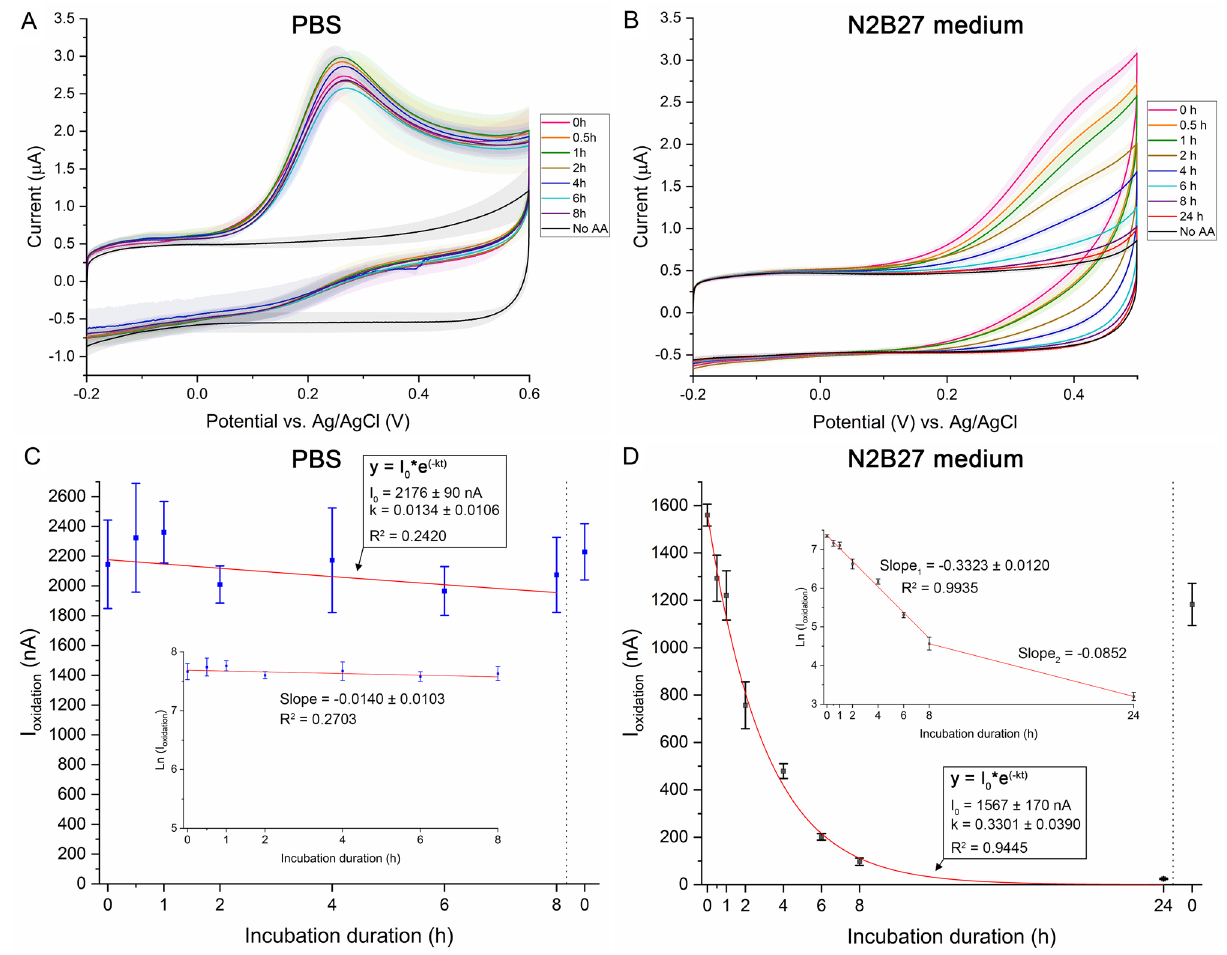
Figure 1. The concentration of ascorbic acid remains stable in PBS but decreases rapidly in culture medium, as is illustrated with cyclic voltammograms ( A , B ) and analyzed oxidation currents ( C , D ) at different incubation durations. Thick traces in ( A , B ) depict averaged trace (n = 3), whereas shaded region depicts SD. Analyzis graphs ( C , D ) show mean average AA oxidation current that is plotted with SD depicted by error bars. In N2B27 medium, the relationship between AA concentration and incubation duration followed accurately the pseudo 2 first-order chemical reaction rate equation ( R = 0.9445). Linearization of the current ( D , inlet) showed that this fit was near-perfect between 0 and 8 hour incubation duration, after which the fit broke down. In contrast 2 to N2B27 medium, the goodness of fit was poor for AA oxidation in PBS ( R = 0.2420) and the variation